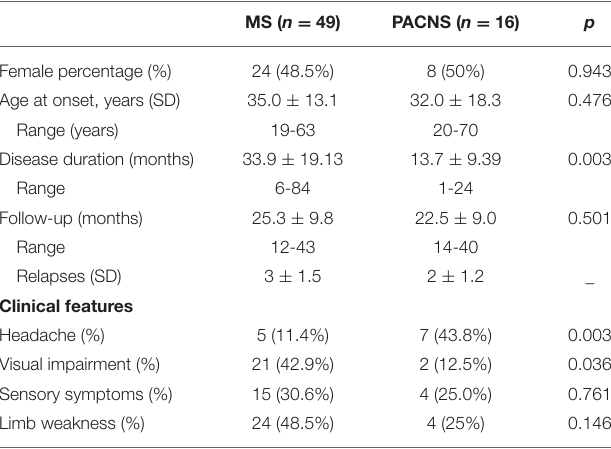
TABLE 1 | Clinical features of multiple sclerosis (MS) and primary angiitis of central nervous system (PACNS).